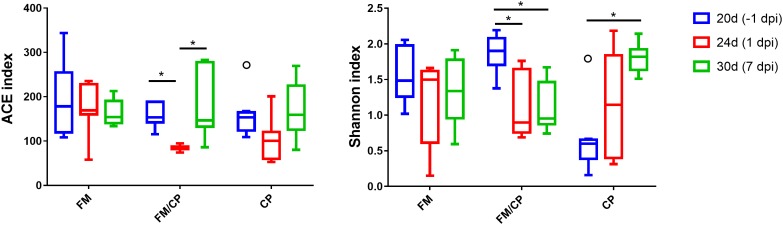
Estimates of alpha diversity for the gut microbiota from intestine content. ∗p < 0.05, ANOVA test.